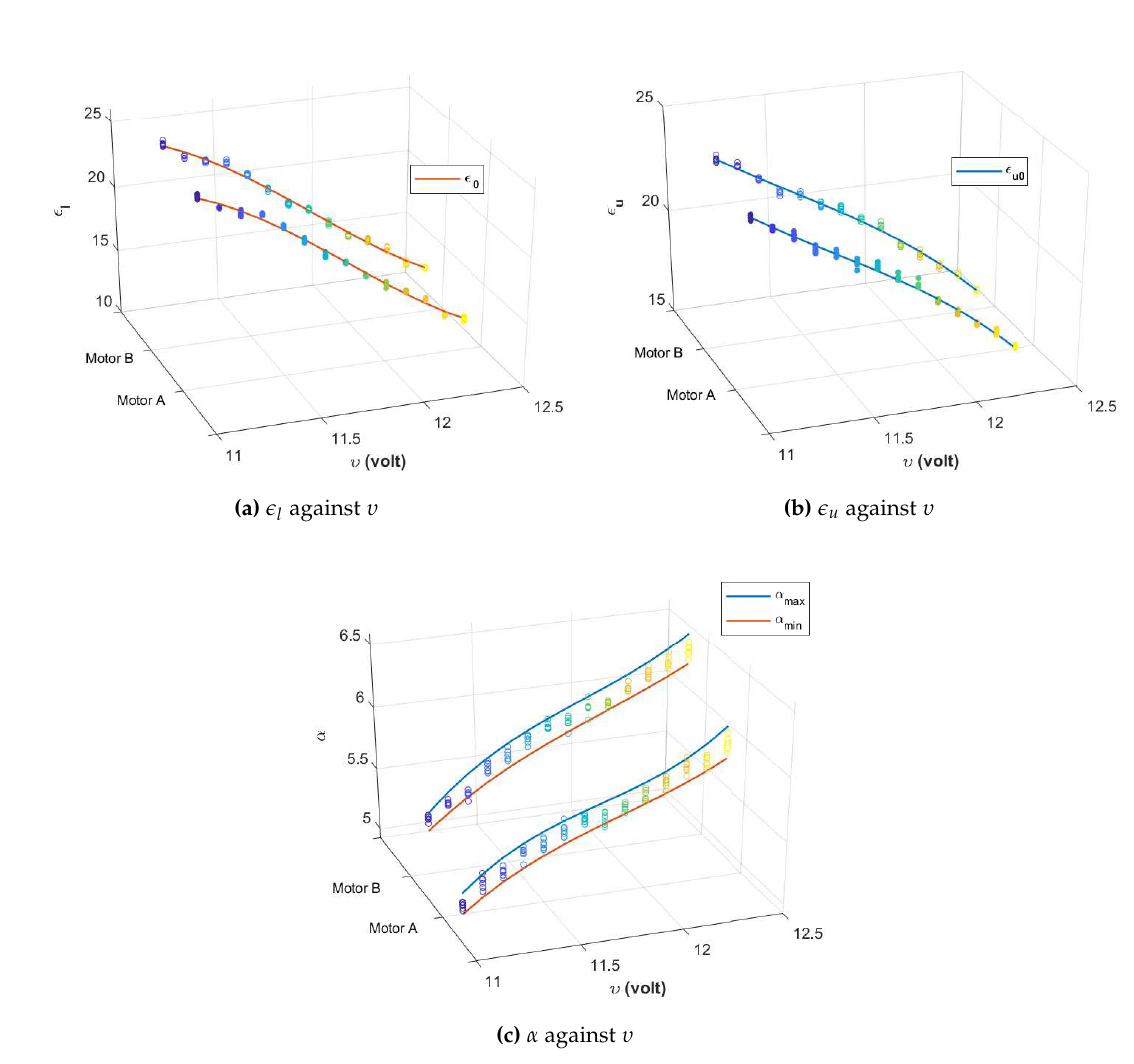
Figure 4. Scatter plots represent the observed values while the curved line plots represent the lines of best fit based on polynomial